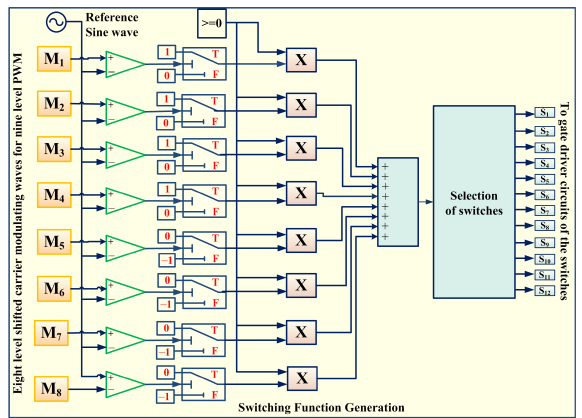
Figure 5. Generation of switching pulses for sine-PWM